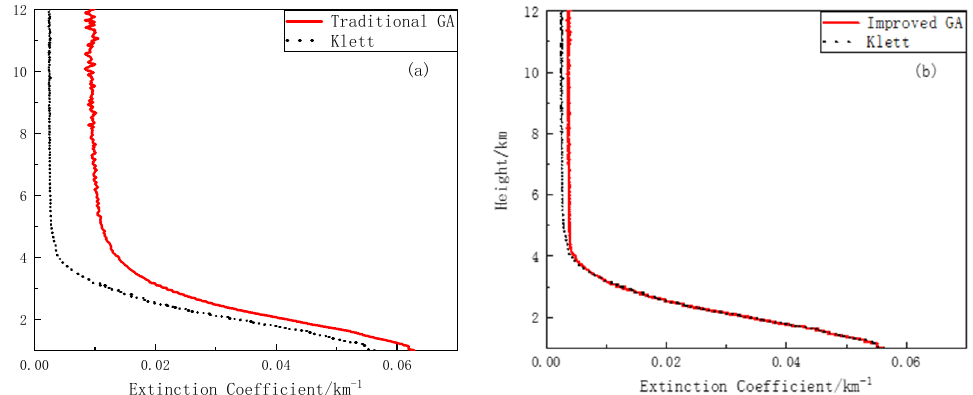
Figure 5. Inversion results obtained under sunny conditions: ( a ) using the simple genetic algorithm and the Klett method, and ( b ) using the improved genetic algorithm and the Klett method.